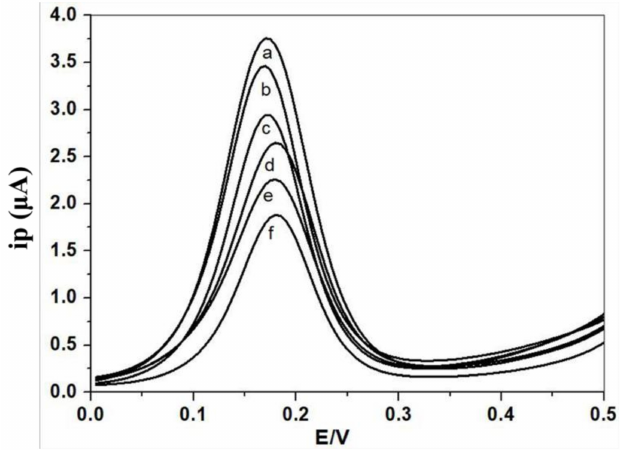
Figure 8. DPV responses in licorice extract of 4% solid content: (a) 5.0 × 10 2 CFU/mL, (b) 5.0 × 10 3 CFU/mL, (c) 5.0 × 10 4 CFU/mL, (d) 5.0 × 10 5 CFU/mL, (e) 5.0 × 10 6 CFU/mL and (f) 5.0 × 10 7 CFU/mL E. coli .